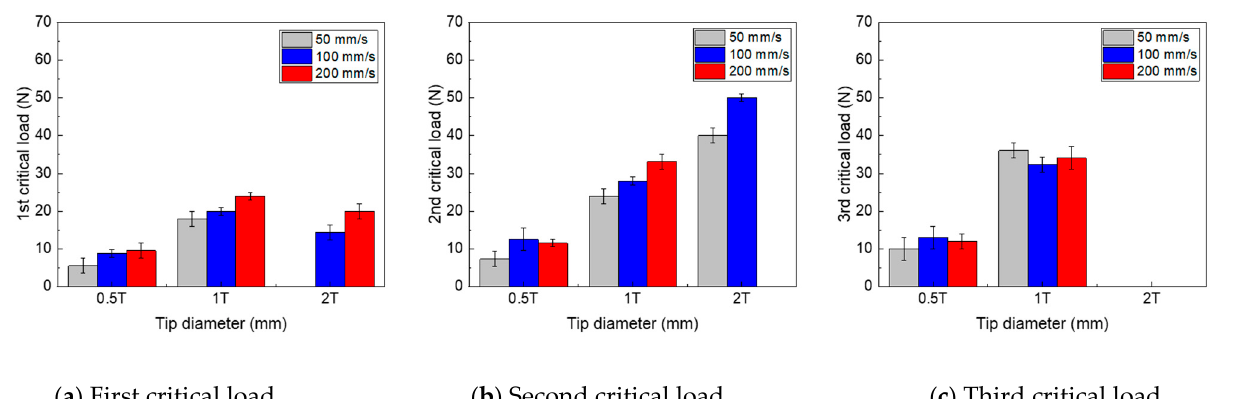
Figure 4. Critical loads of multilayer coat at various scratch speeds and tip sizes.